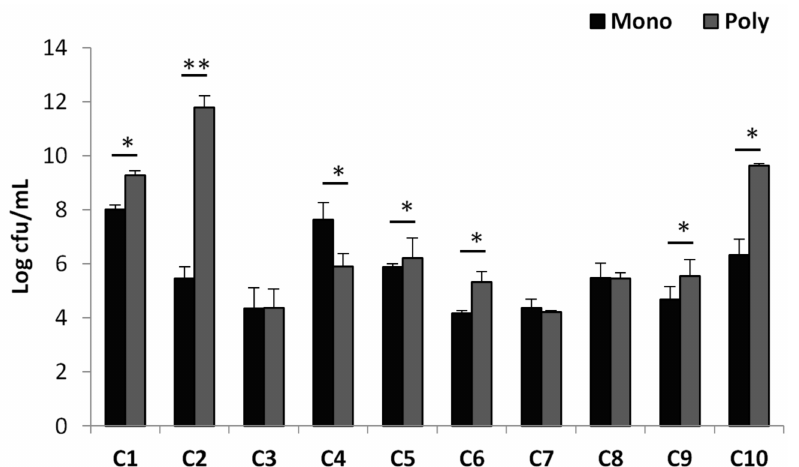
Figure 1. Viable cell counts of P. aeruginosa in mono- and triple-species biofilms. C1: Ciprofloxacin + Curcumin; C2: Ciprofloxacin + Azathioprine; C3: Ciprofloxacin + Resveratrol; C4: Ciprofloxacin + Catechin hydrate, C5: Ciprofloxacin + Baicalein, C6: Ciprofloxacin + L-canavanine, C7: Ciprofloxacin + 4-nitropyridine N-oxide; C8: Ciprofloxacin + p-benzoquinone; C9: Ciprofloxacin + Esculetin hydrate; C0: Ciprofloxacin + Cinnamaldehyde. * Significant ( p < 0.05), ** Significant ( p < 0.01). The results are shown as the average ± standard